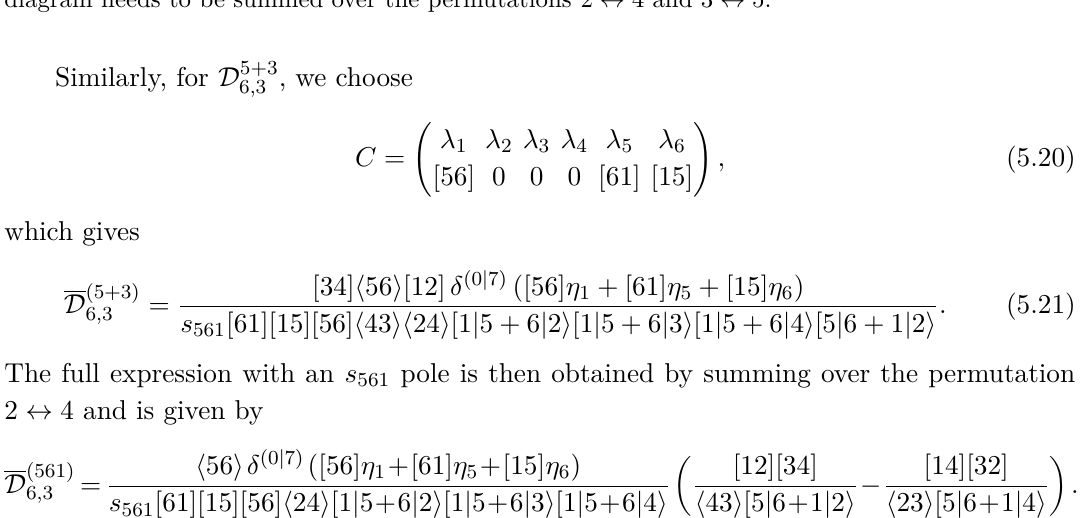
Figure 12 . On-shell diagram combining two 4-point amplitudes with alternating helicities. This diagram needs to be summed over the permutations 2 ↔ 4 and 3 ↔ 5